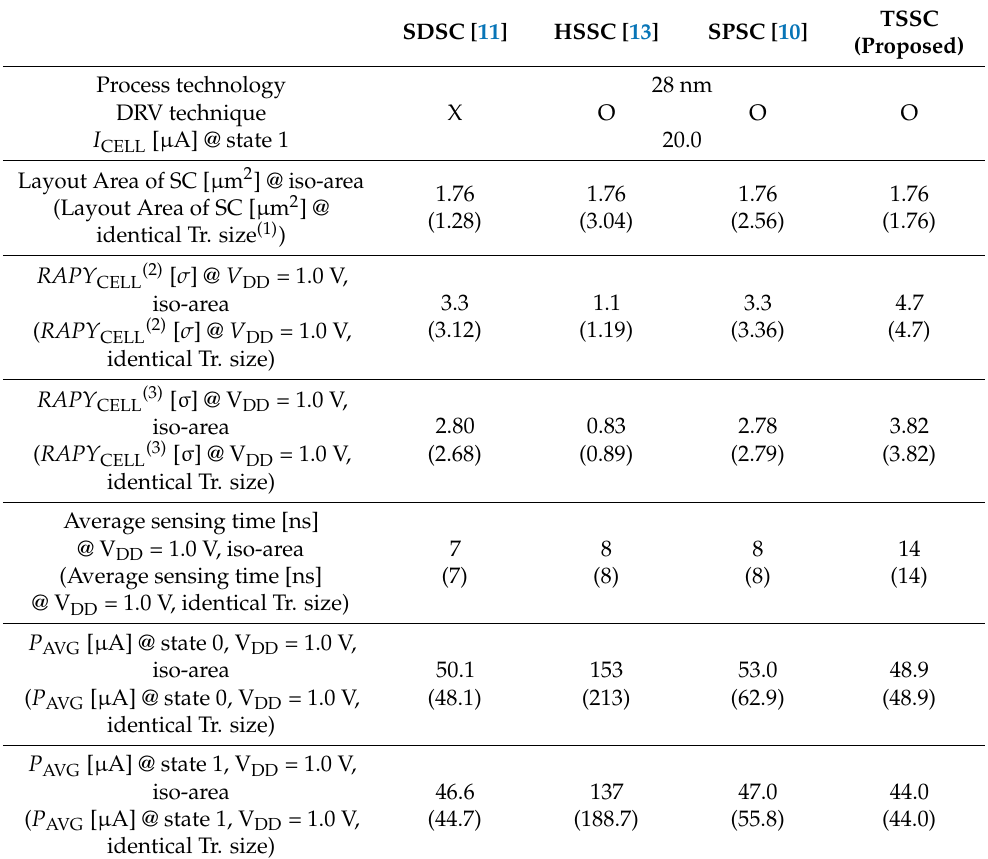
Table 1. Summary of the simulation results in terms of iso-area (identical Tr. size) and